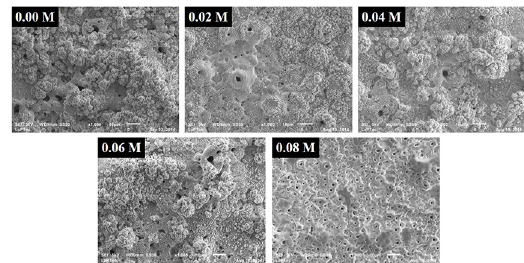
Figure 5. SEM micrographs of titanium samples treated by PEO with different C M